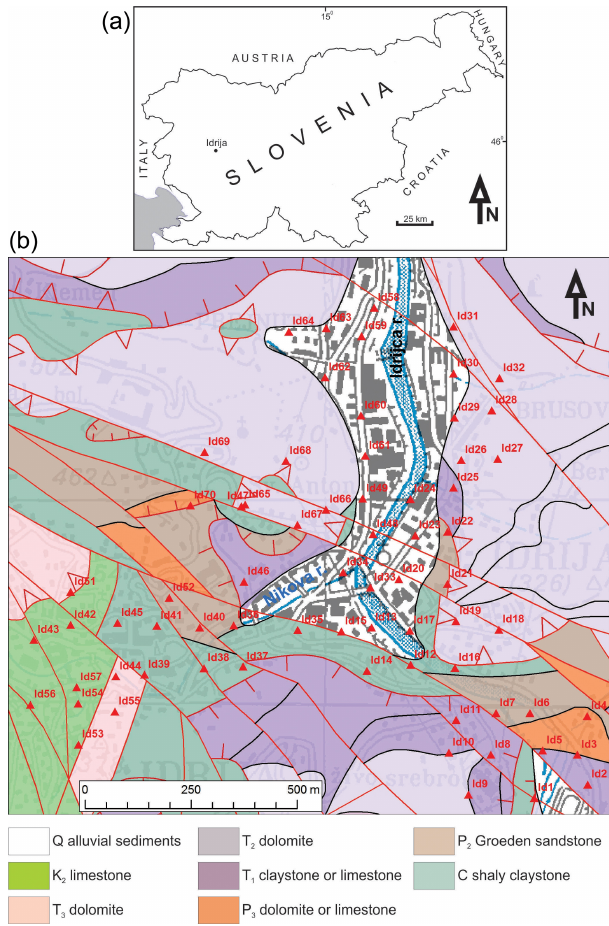
Figure 1. (a) Location of the Idrija town in Slovenia. (b) Geolog- ical map of the Idrija town area (after Mlakar and ˇCar, 2009). Red triangles indicate points of microtremor